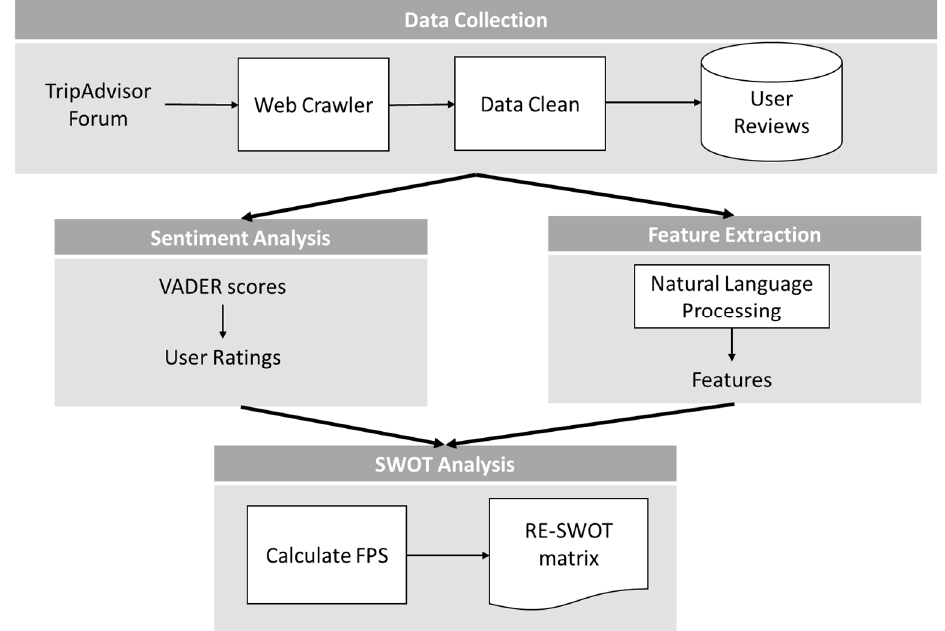
Figure 3. Process used in the proposed method.